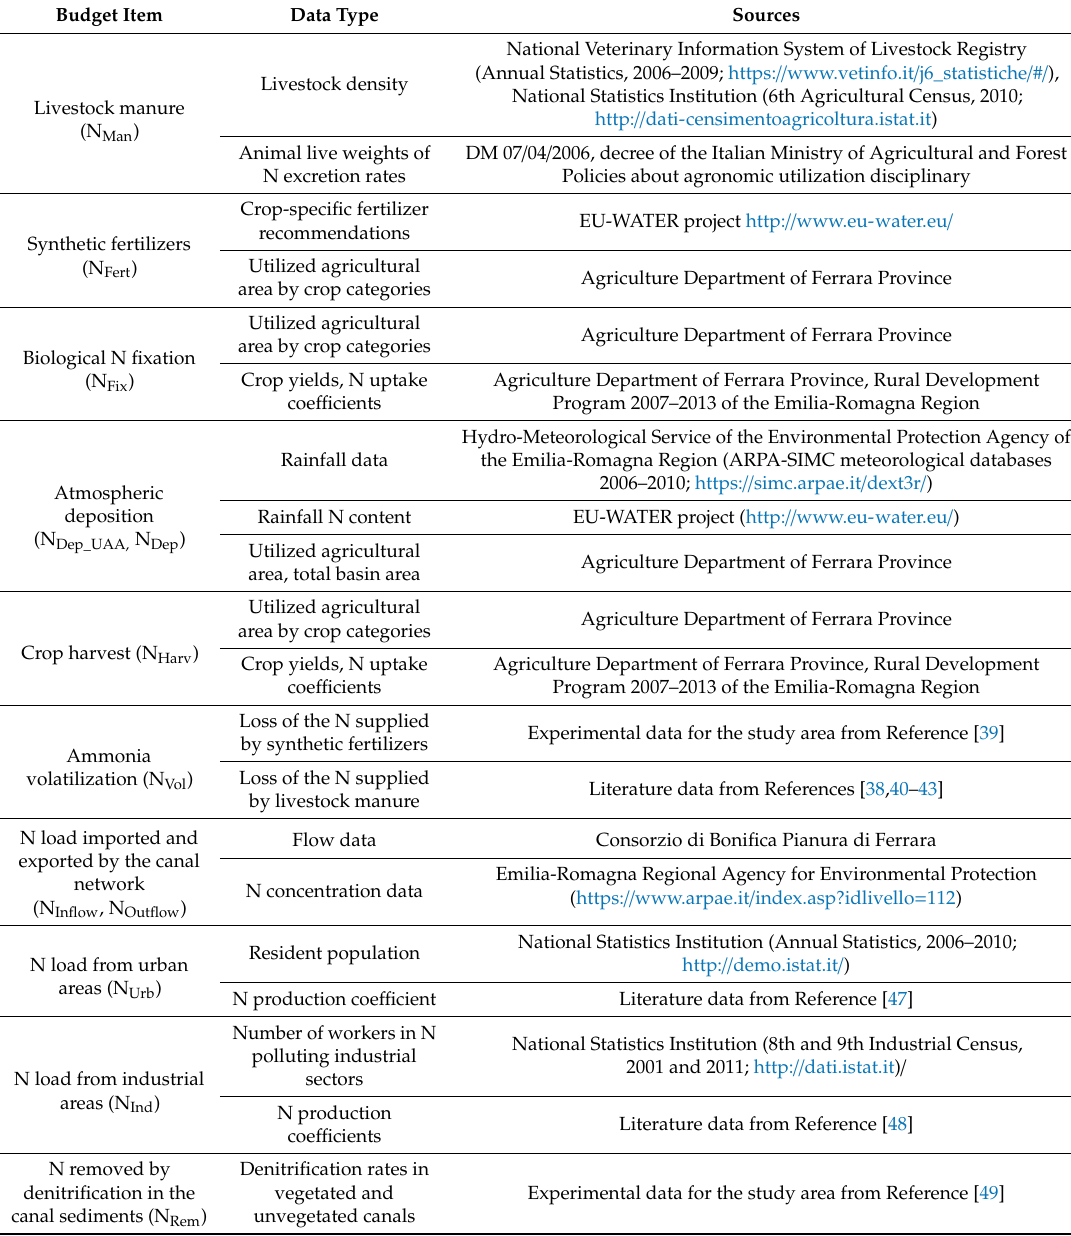
Table 1. Sources of statistical data and coe ffi cients used for the calculations of N budget in agricultural soils and waters of the Po di Volano-Sacca di Goro